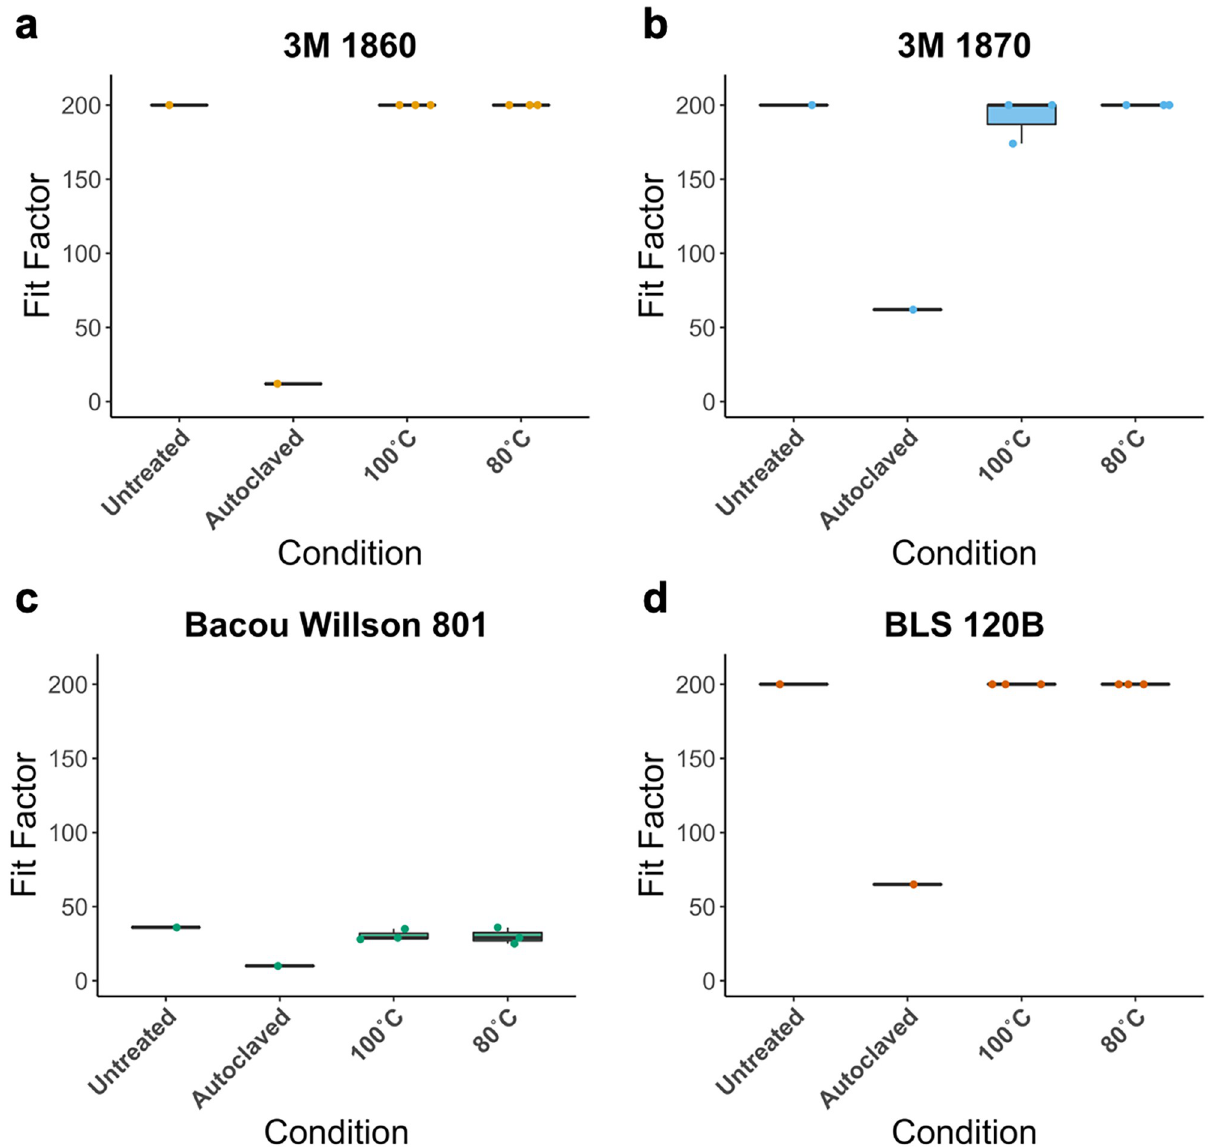
Fig 2. Quantitative fit factors of N95 respirators. Quantitative fit factors of N95 (a) 3M 1860, (b) 3M 1870, (c) Bacou Willson 801, and (d) BLS 120B respirators, treated with dry heat at 100˚C for 30’ or 80˚C for 60’ (n = 3), compared to untreated and autoclaved controls (n = 1).